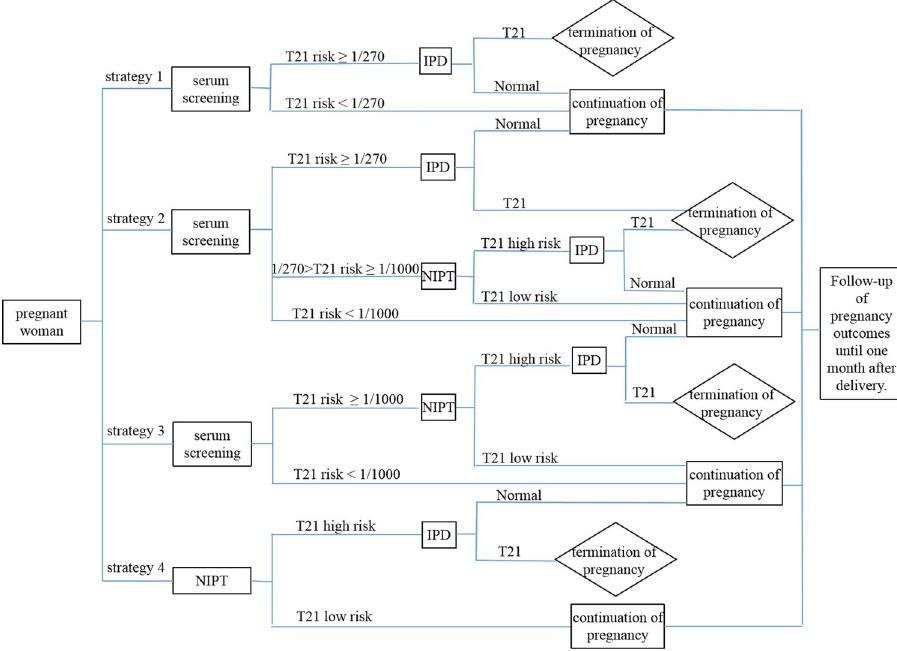
Fig 1. Flowchart of four screening strategies. NIPT, noninvasive prenatal testing; IPD, invasive prenatal diagnosis.